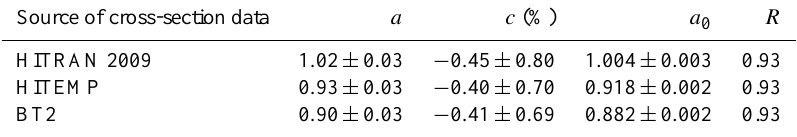
Table 8. Comparison of LP-DOAS data with data from the meteorological station at the CVAO: the measured mixing ratio m is compared to the calculated mixing ratio w from the data of the weather station. f (w) = a · w + c and f 0 (w) = a 0 · w are fitted measurement error- weighted to the observations m . The correlation coefficient or Pearson’s R is constant for all cases. The best agreement in overall absorption size in the W3 interval is observed for HITRAN 2009. The uncertainty of the meteorological measurements is estimated to result in a relative uncertainty in water vapour mixing ratio of 7%. The relative observed slopes a and a 0 agree with expectations from Table 3. Source of cross-section data a c (%) a 0 R HITRAN 2009 1 . 02 ± 0 . 03 − 0 . 45 ± 0 . 80 1 . 004 ± 0 . 003 0.93 HITEMP 0 . 93 ± 0 . 03 − 0 . 40 ± 0 . 70 0 . 918 ± 0 . 002 0.93 BT2 0 . 90 ± 0 . 03